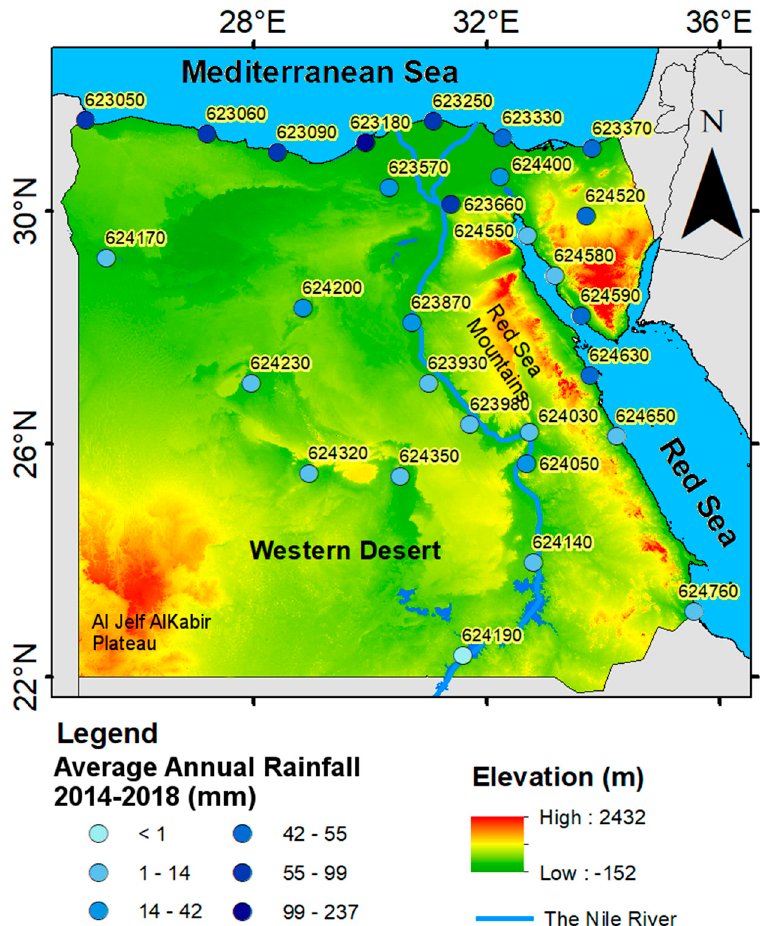
Figure 1. Egypt topography and the location of rainfall gauges. The average annual rainfall at 29 stations for the period 2014–2018 is used to show the rainfall distribution.